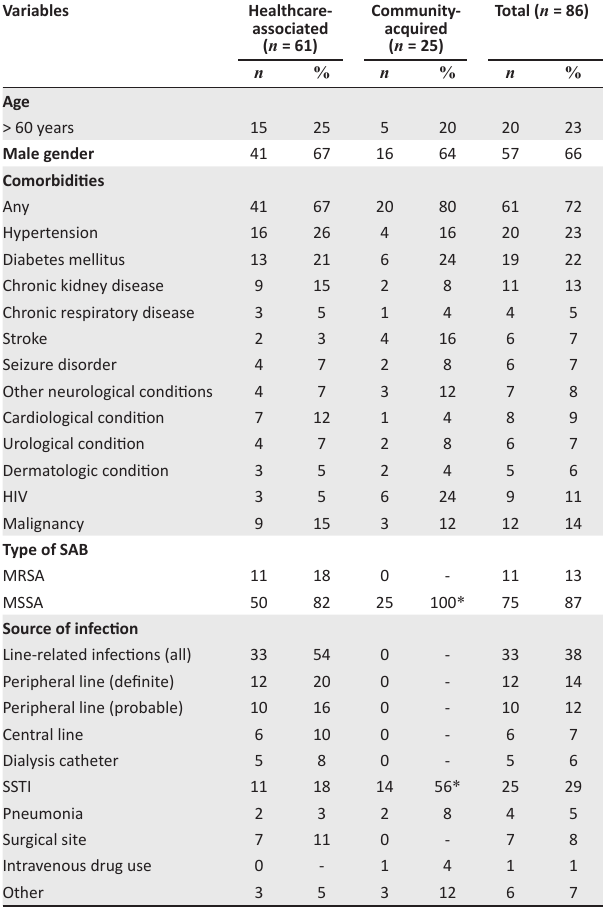
TABLE 1: Characteristics of patients admitted to the hospital with Staphylococcus aureus bacteraemia over the 12-month period. Variables Healthcare- associated